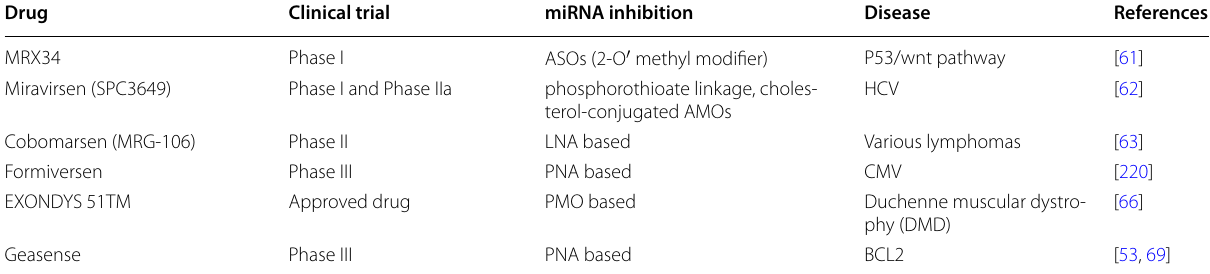
Table 2 Approved miRNA-based drugs for miRNA therapeutics Drug Clinical